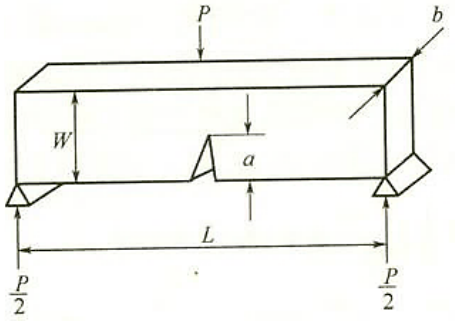
Figure 6. Shape, size, and stress diagram of Chevron Notch (CN) sample. Table 1. Maximum load of layered Al 2 O 3 /PMMA composites with different initial solid phase content.